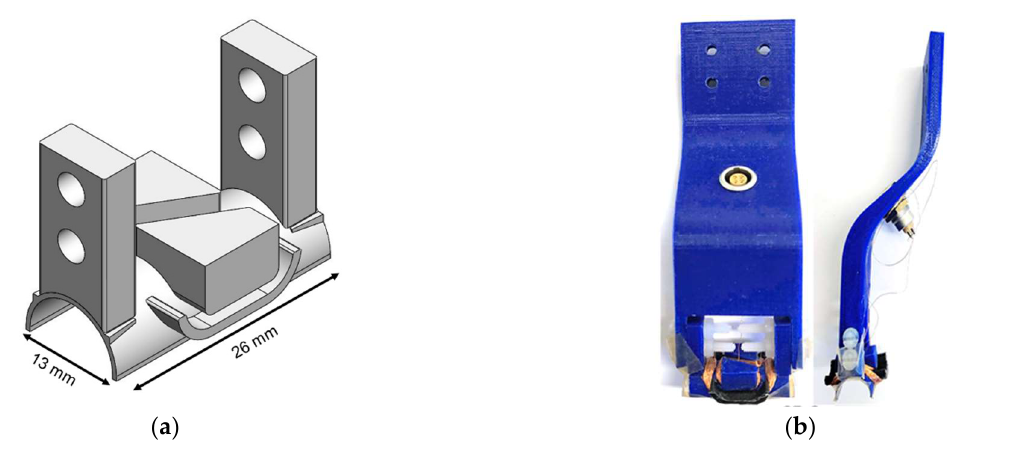
Figure 20. Probe production; ( a ) Coil support CAD model; ( b ) Probe assembled, front and side view.